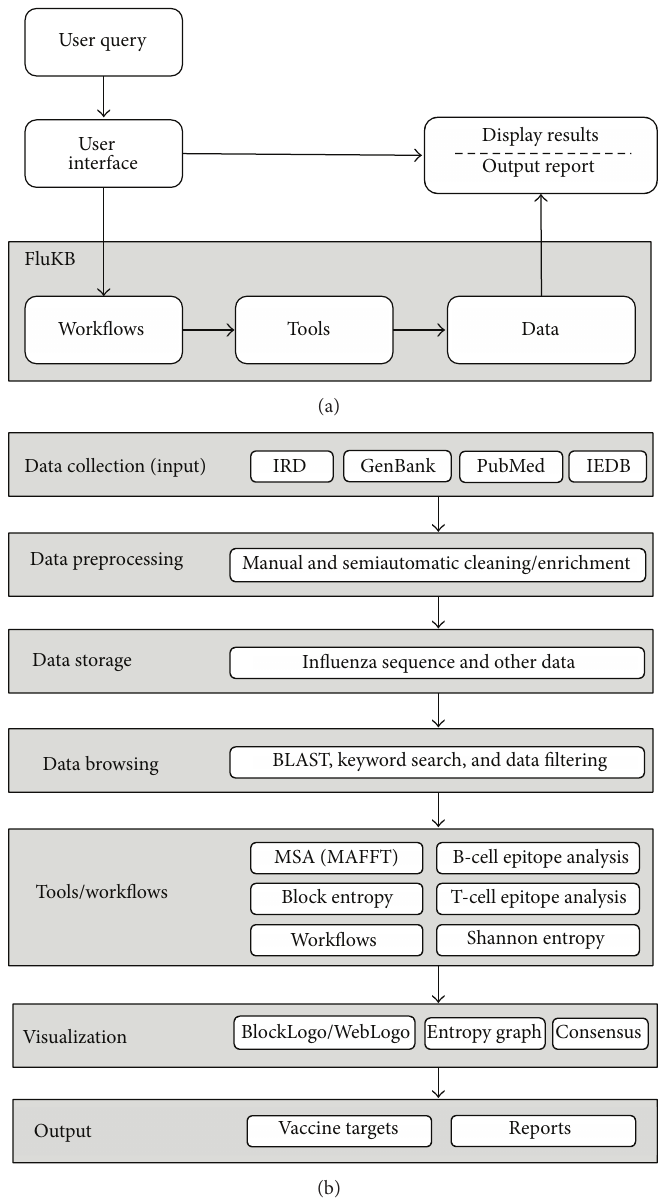
Figure 1: Overview of the architecture of FluKB. (a) Users can access FluKB through an interactive user interface where they can select specific data and tools or deploy a predefined workflow. (b) Top to bottom: data are collected, cleaned, and enriched. Higher-level knowledge extraction is enabled by utilization of tools assembled into